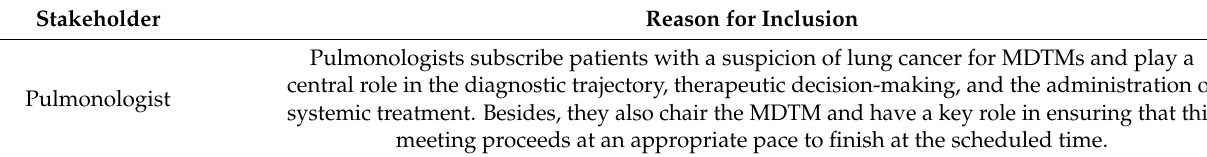
Table 1. Reasons to include MDTM